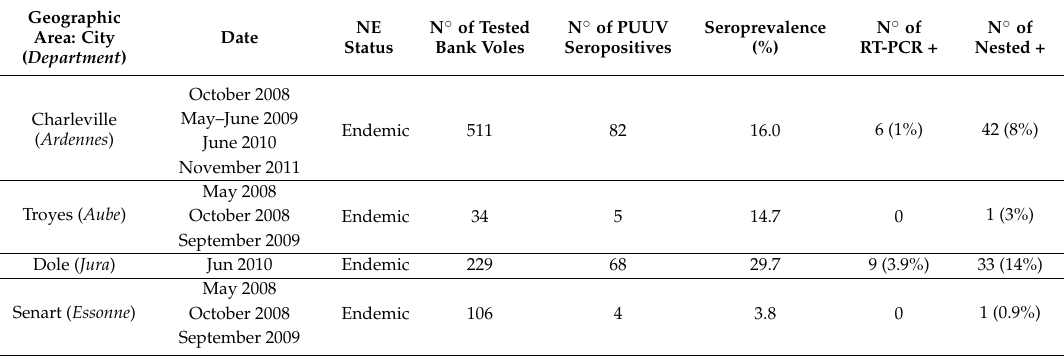
Table 1. Results of bank voles captures and